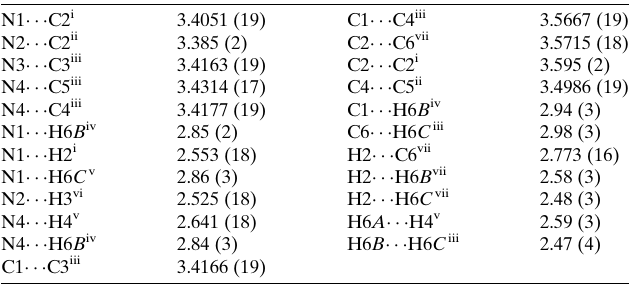
Table 2 Selected interatomic distances (A˚